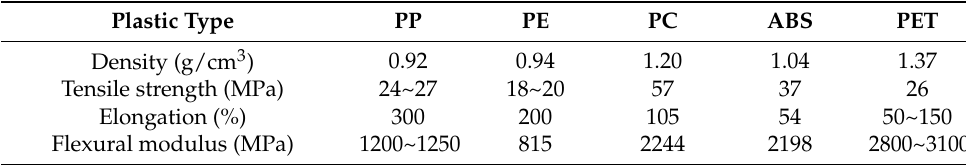
Table 4. Physical properties of plastic aggregates.